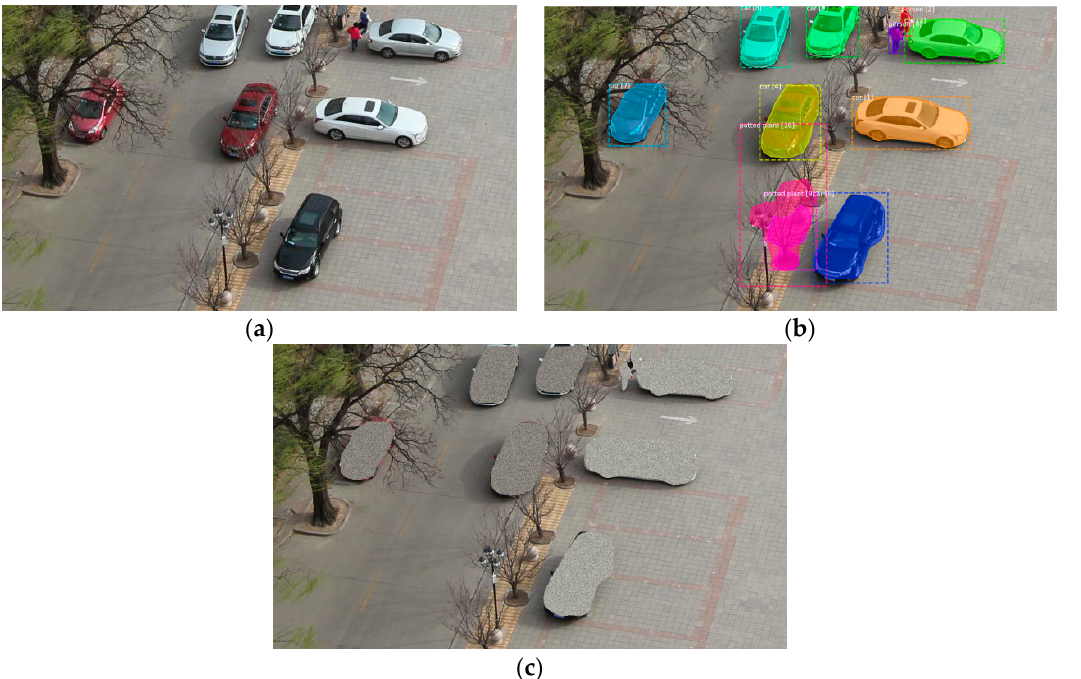
Figure 8. ( a ) Image in experiment 1; ( b ) the result of instance segmentation; ( c ) covering the objects with similar color masks.